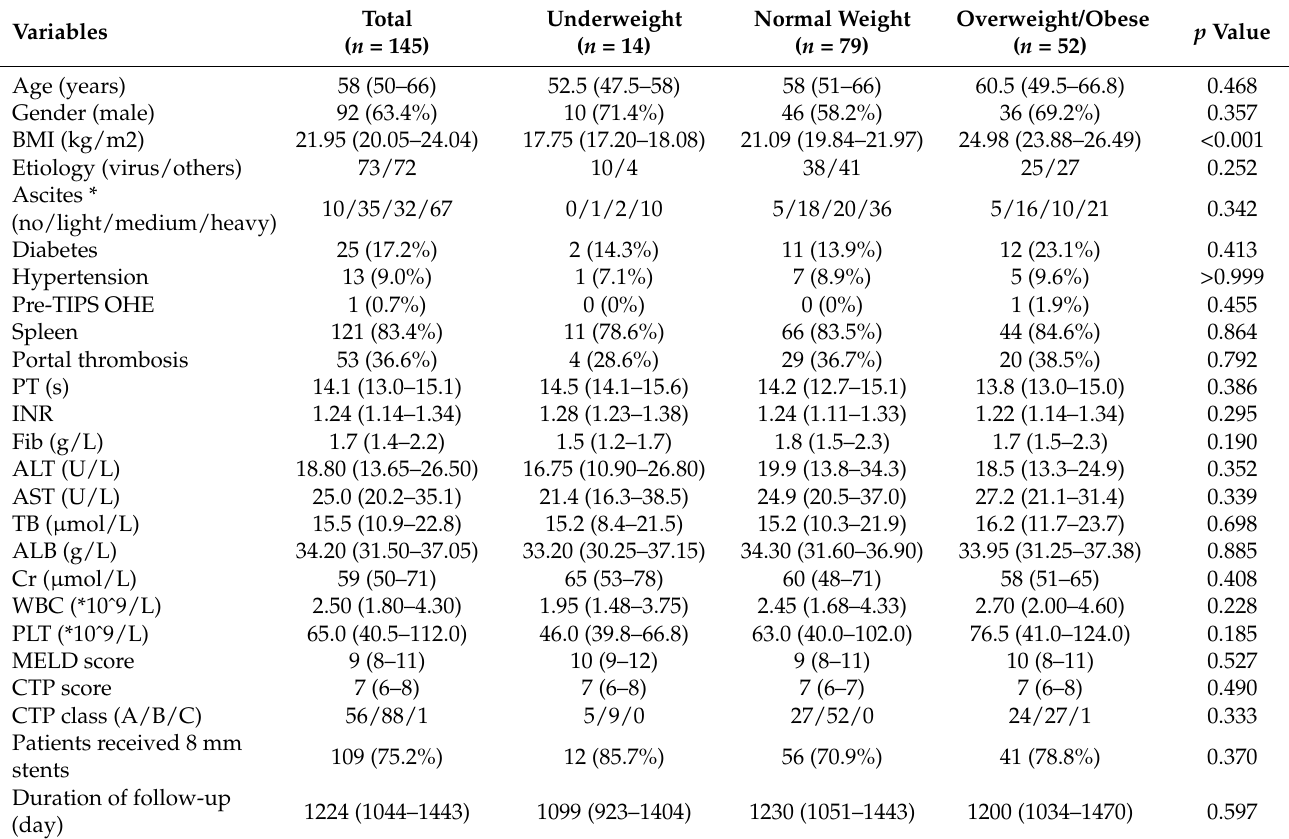
Table 1. Characteristics of patients just before the TIPS